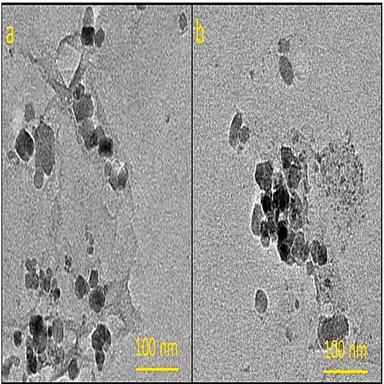
TEM images of (a) FG2I and (b) FG2E.